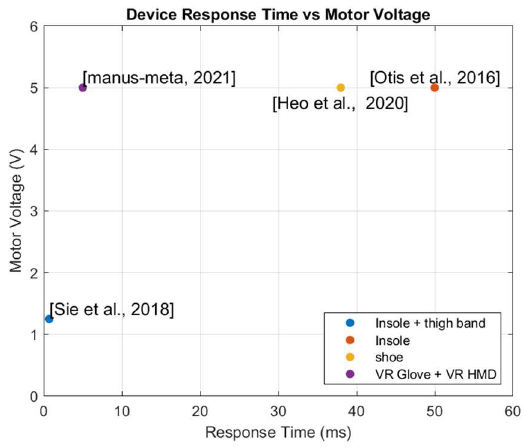
Figure 4. A scatter plot showing the response time of the haptic system against the motor voltage [55,56,65,70].